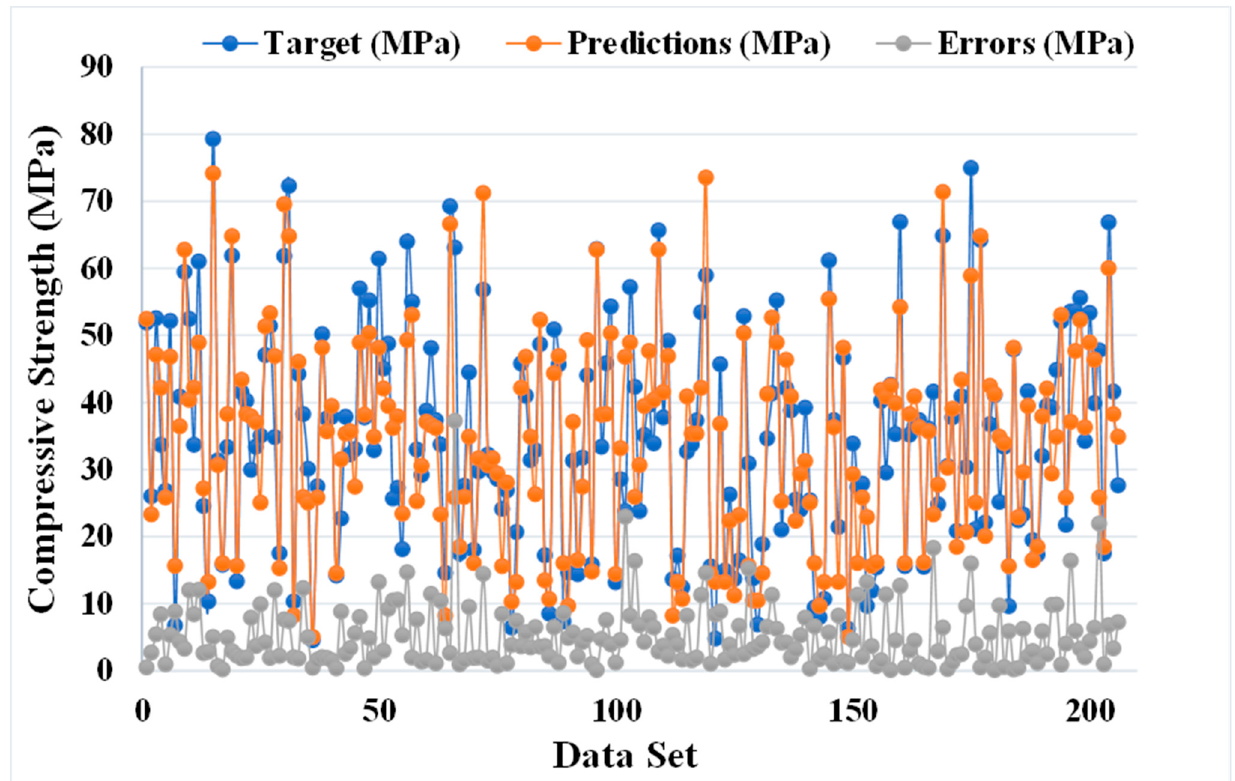
Figure 9 indicates the statistical analysis interpretation of the actual and forecasted results for the CS of SCM-based concrete for the DT model. The DT also gives the output